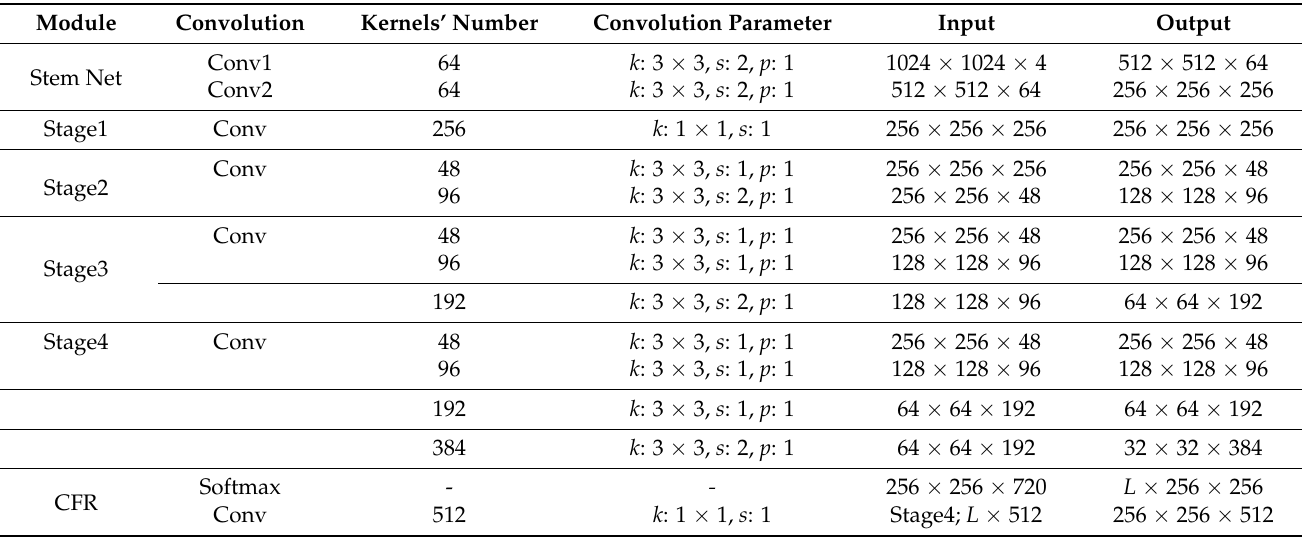
Table 3. The structure table of the HRNet-CFR